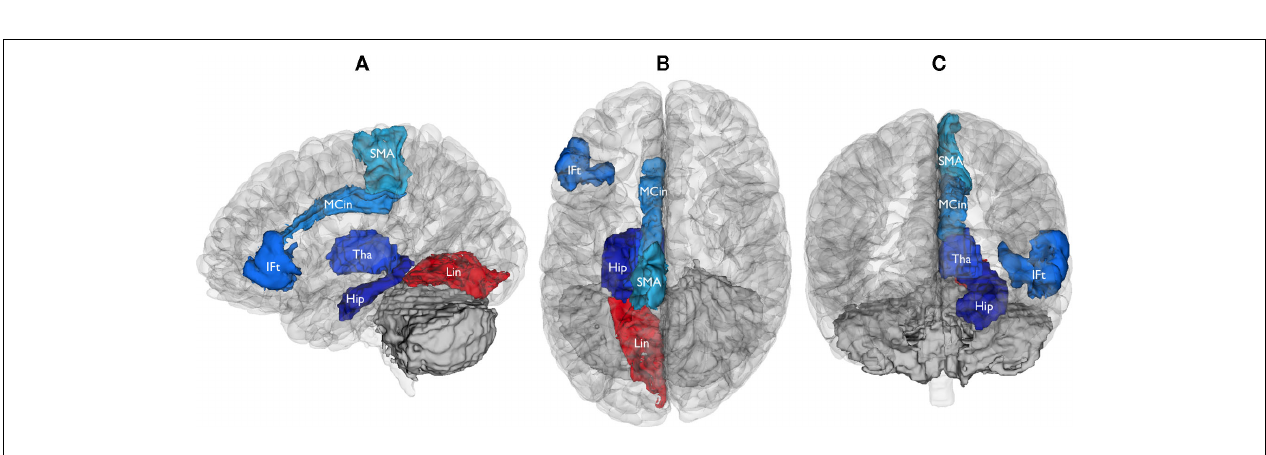
functional connectivity ( p < 0.0001, FDR-corrected). Reduced functional connectivity involved the right anterior cerebellar hemisphere (IFt, inferior frontal gyrus, triangular part; SMA, supplementary motor area; MCin, Middle Cingulate gyrus; Hip, Hippocampus;Tha,Thalamus) and anterior vermis of the cerebellum (Hip, Hippocampus;Tha,Thalamus). Increased functional connectivity involved the posterior cerebellar vermis (Lin, Lingual